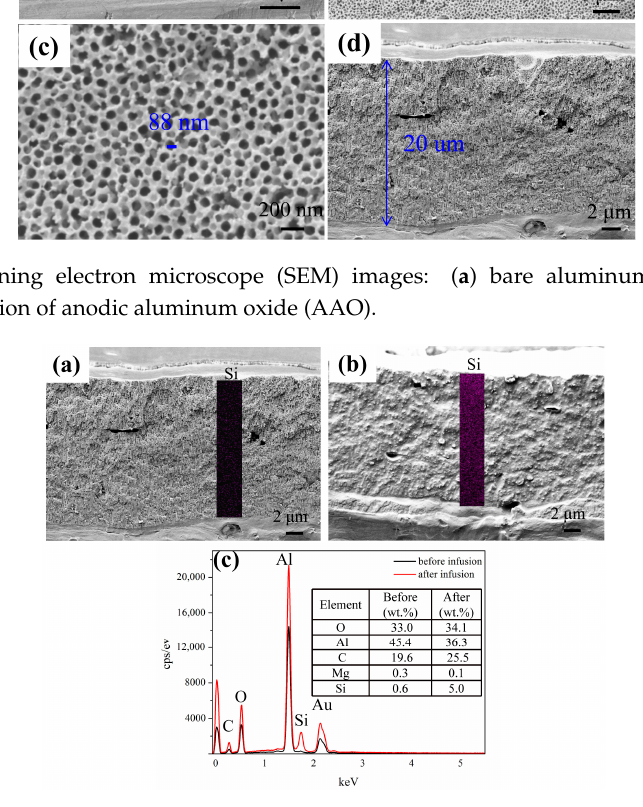
Figure 4. Contact angle of bare Al ( a ) and the SLIPS filled with 10 mPa·s ( b ), 20 mPa·s ( c ), 50 mPa·s ( d ), 100 mPa·s ( e ), and 200 mPa·s ( f ) of silicone oil. 3.2. Slippery Properties Silicone oil with different viscosities (10, 20, 50, 100, 200 mPa·s) was used for the infusion of AAO surfaces. The sliding angles (SAs) and sliding speed are illustrated in Figure 5. The lowest viscosity silicone oil used (10 mPa·s) produces outstanding slippery properties, with low water sliding angle values (0.8°) and high sliding velocity (25 mm/s). As shown in Figure 4, the sliding angles of water droplets on the SLIPS increase with increasing silicone oil viscosity. The sliding velocities of droplets on the SLIPS fall when the silicone oil viscosity increases. The results demonstrate that the slippery